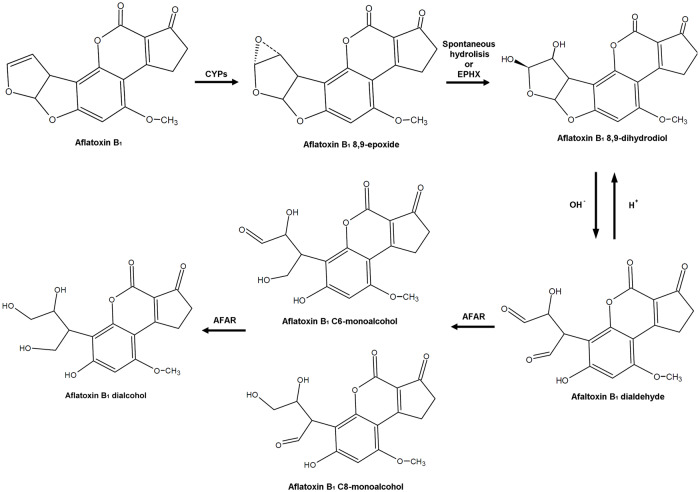
Bioactivation of aflatoxin B1 into aflatoxin B1 8,9-epoxide through cytochrome P450 enzymes (CYPs).Spontaneous hydrolysis of the epoxide or the enzymatic activity of epoxide hydrolase (EPHX), produce aflatoxin B1 8,9-dihydrodiol which in a pH dependent manner equilibrates with aflatoxin B1 dialdehyde. Enzymatic reduction of aflatoxin B1 dialdehyde into aflatoxin B1 C6-monoalcohol and aflatoxin B1 C8-monoalcohol is carried out by aflatoxin B1 aldehyde reductase (AFAR), which in turn can also reduce these monoalcohols into aflatoxin B1 dialcohol.